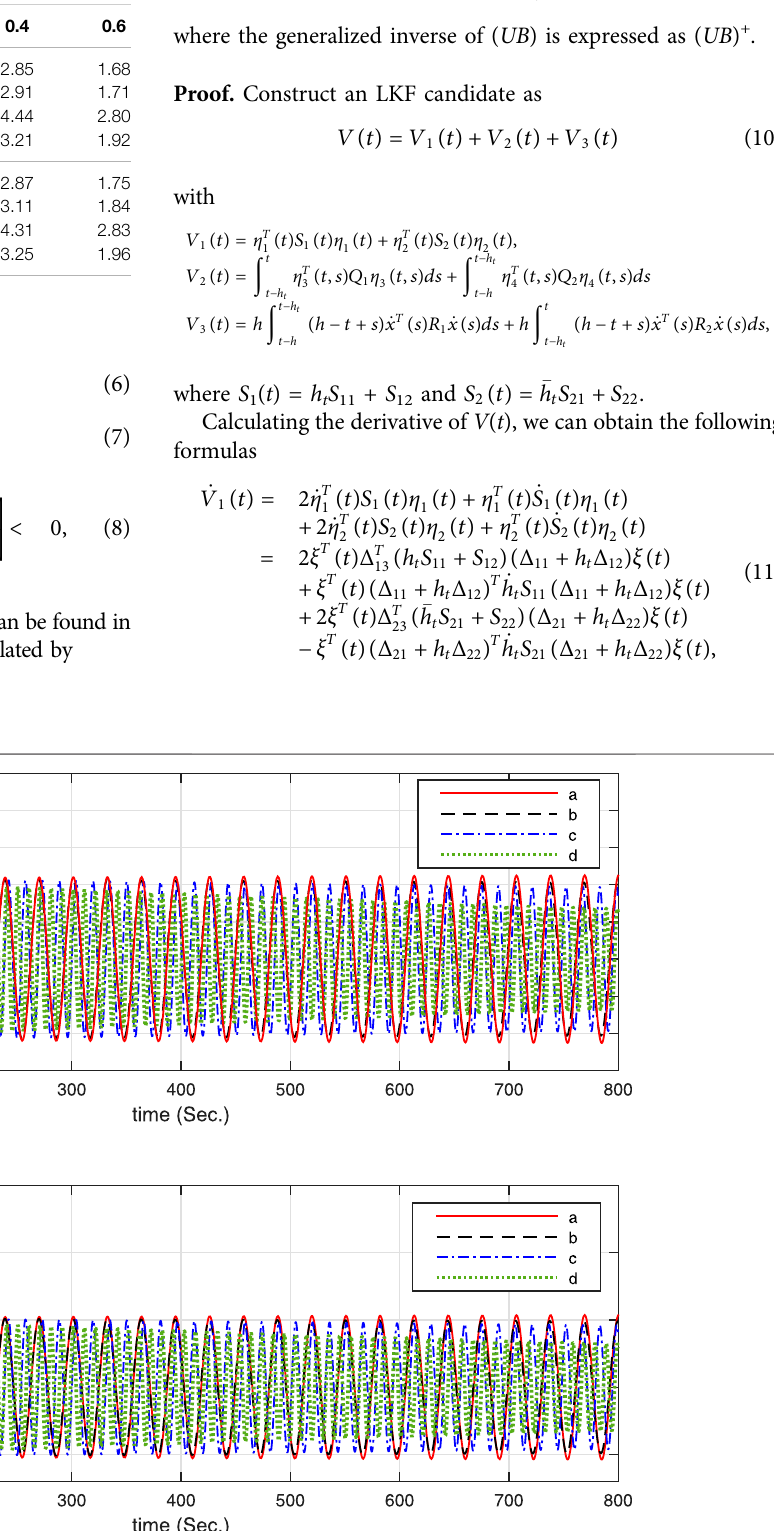
Frontiers in Energy Research |